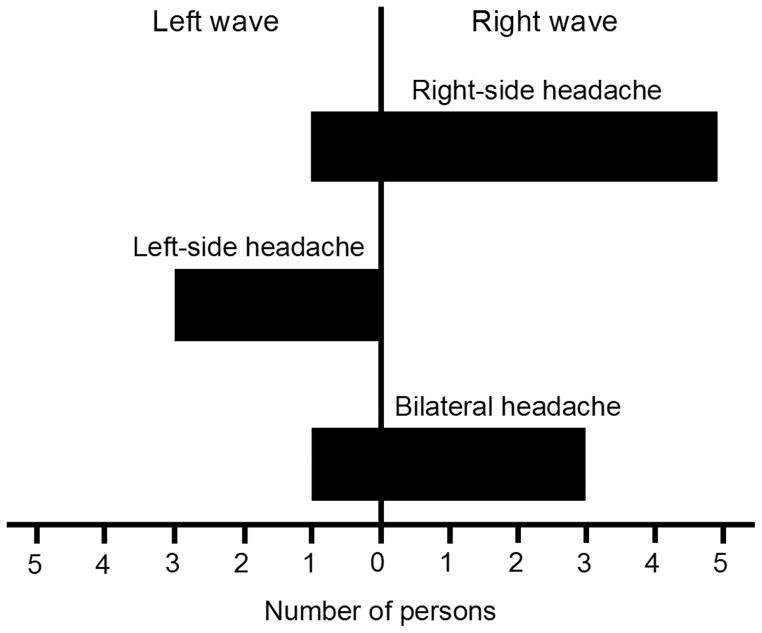
Number of the migraine patients possessing either right or left transverse wave of blood perfusion in relation to the side of the headache.